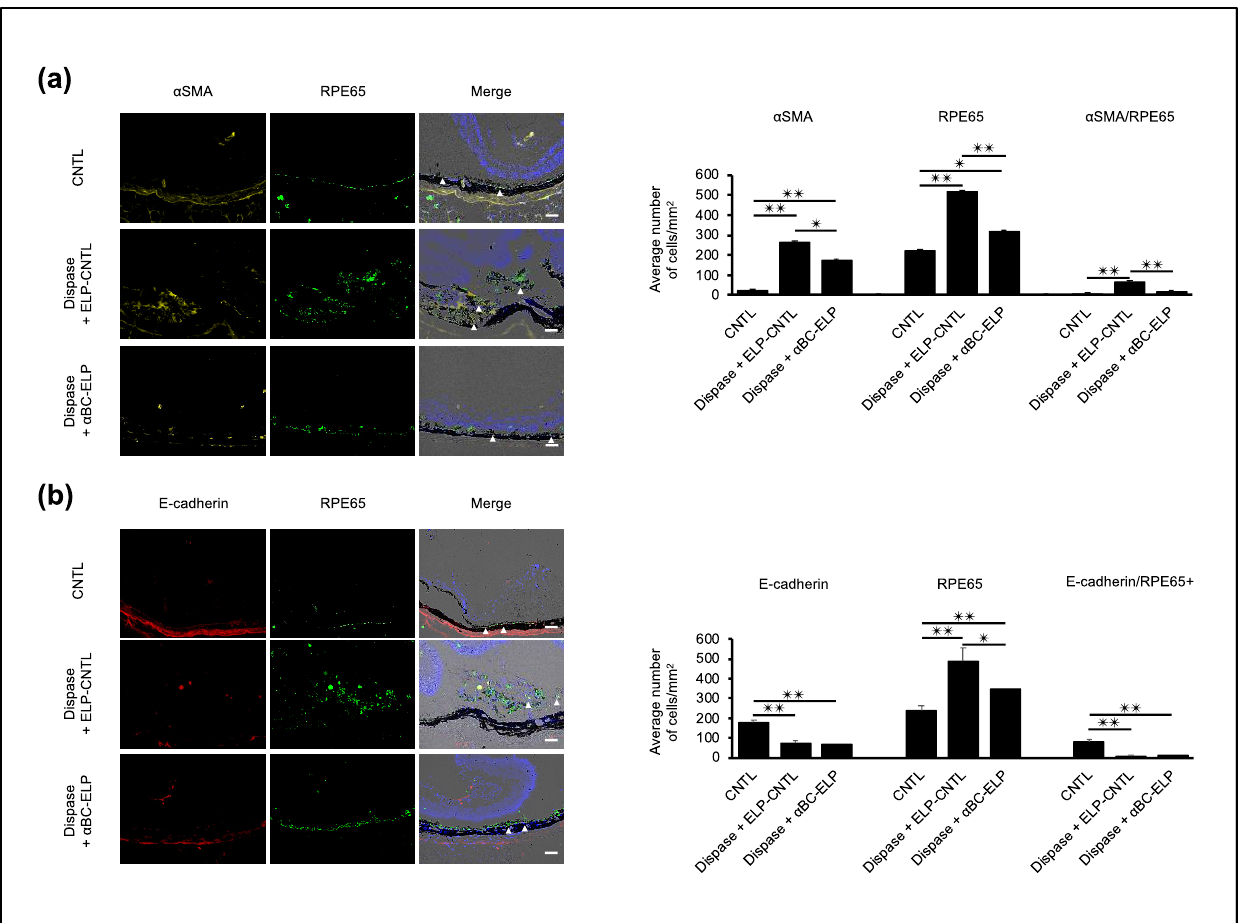
Figure 10. αBC -ELP inhibits EMT in dispase-induced PVR in mice. The experimental protocol is shown in Figure 8a. Double immunofluorescence staining for αSMA or E -cadherin with RPE65 in retinal sections ( a , b ). Nuclei are stained blue. White arrowheads indicate co-staining of αSMA/RPE65 and E -cadherin/RPE65, respectively. Quantification of number of positive cells for αSMA, RPE65, E -Cadherin and co-localization is shown in the bar graphs. Values are means ± SEM. N.S.: not significant, αBC - ELP: αB crystallin -Elastin-like peptide. Scale bar : 50 μm. * p < 0.05, ** p < 0.01. n = 10.